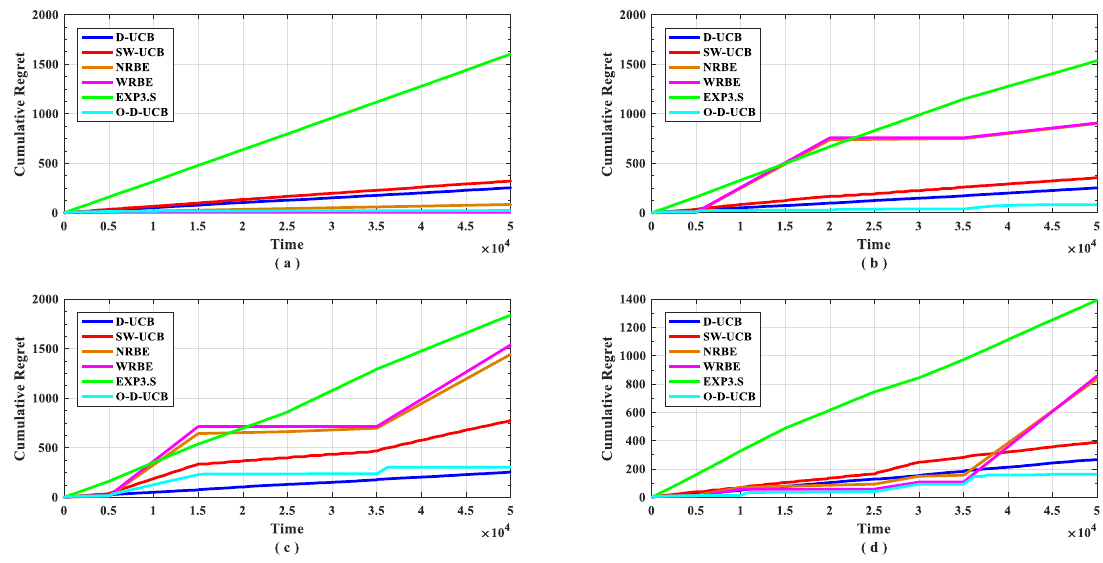
Table 4. D-UCB and O-D-UCB corresponding quantities.